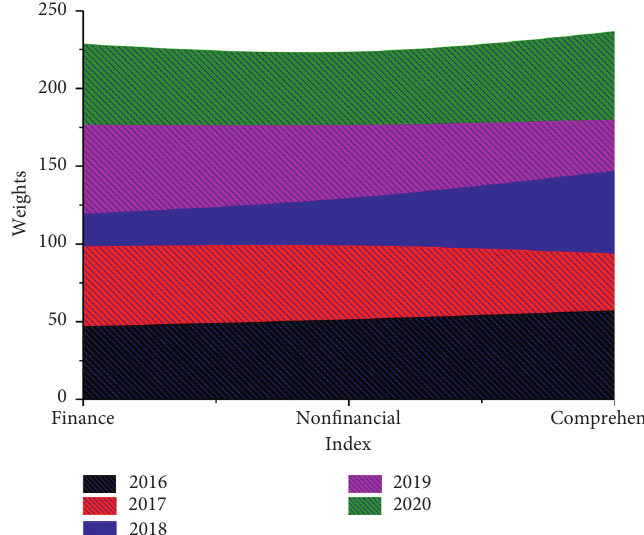
Figure 9: Company financial risk assessment